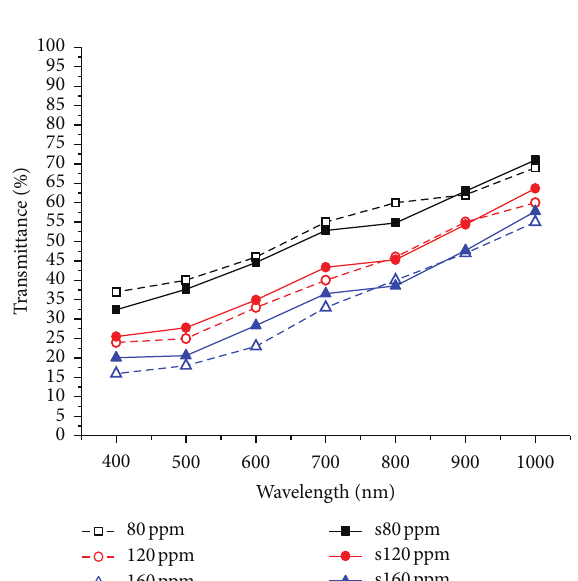
Figure 5: Comparison of transmittance spectra of a diffusion plate with TiO 2 nanoparticles between simulation and experiment. Solid line (—): simulation. Dash line (----):